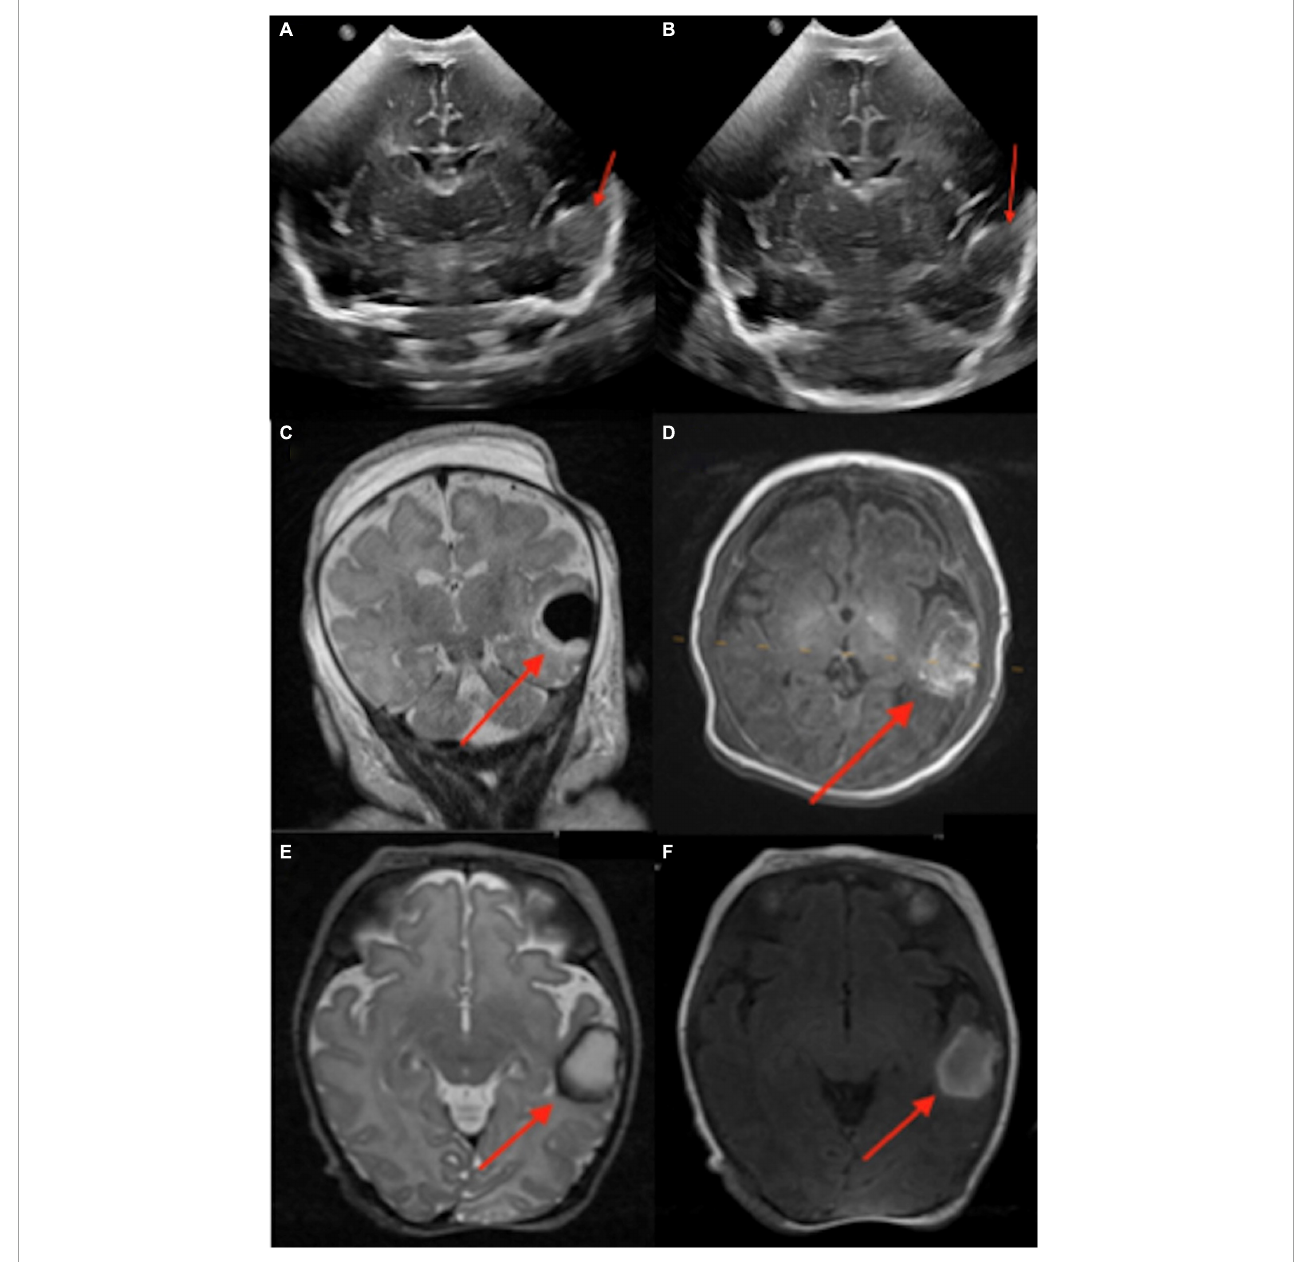
FIGURE4 An infant born at 37 weeks and 3 days, with delivery complicated by shoulder dystocia and brachial plexus injury, was found to have hypoglycemia and seizures after birth. A left temporal lobe intraparenchymal hemorrhage was found in transcranial ultrasound (1 day old, A,B ). This was further delineated on conventional 3-Tesla MRI (4 days old, C,D ) and followed on point-of-care 1-Tesla MRI (35 days old, E,F